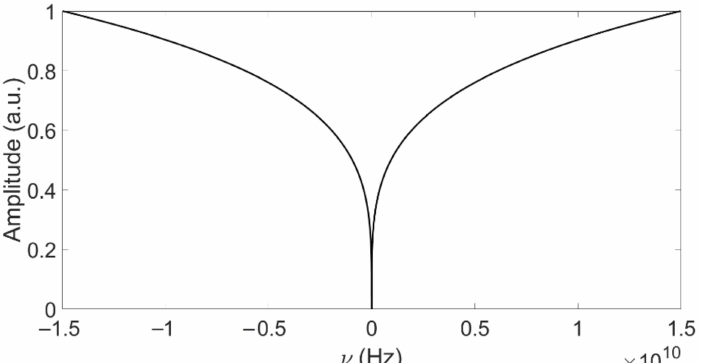
Figure 1. Plot of the operator H n ( ν ) for the 0.33th-order differentiator frequency response in ampli- tude, in baseband